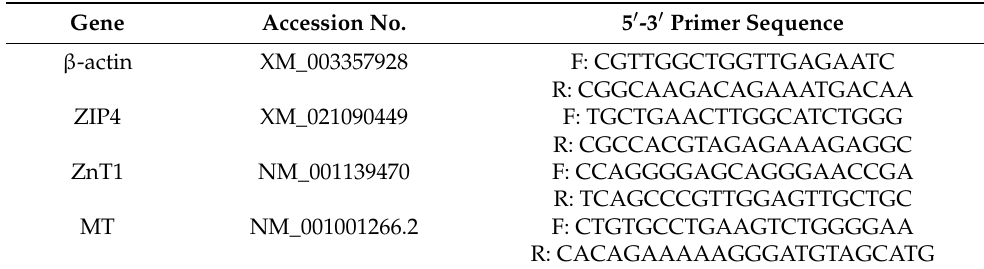
Table 2. Primers used in this